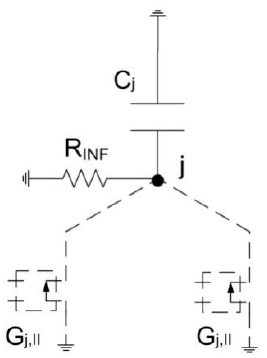
Figure 2. Scheme of the basic network model